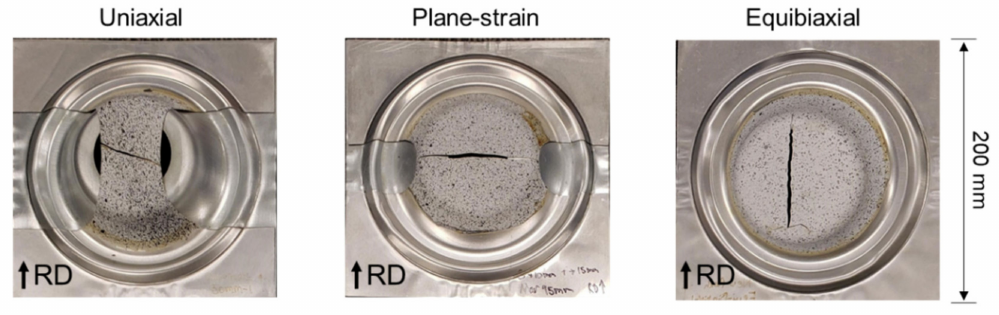
Figure 14. Photograph of the FLC specimens after fracture, for the three strain paths